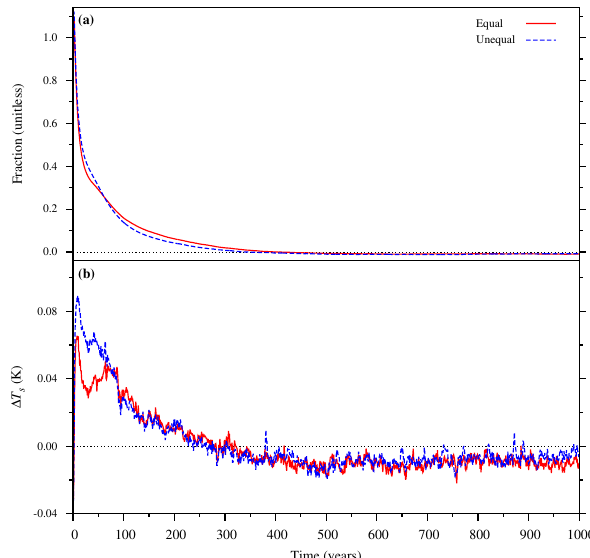
Figure 9. Differences between two distinct spatial patterns of fire pulses both resulting in gross emissions of 100PgC. For the “equal” pattern, the burned area fraction was the same in each fire cell. For the “unequal” pattern, the burned area fraction was two times higher between 27 ◦ S and 27 ◦ N than for other latitudes. (a) Airborne frac- tion of the fire pulse. (b) Change in global mean atmospheric sur- face